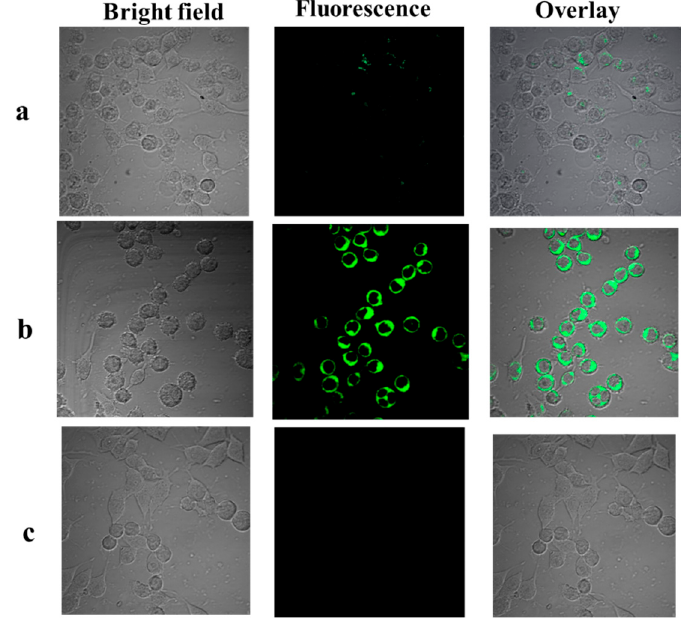
Figure 7. Confocal fluorescence images of HeLa cells. ( Left ) bright-field image; ( middle ) fluorescence image; and ( right ) overlayed image. ( a ) Cells treated with N -ethylmaleimide (NEM) (1 mM) for 30 min followed by incubation with PBD (10 µ M) for 20 min. ( b ) Cells incubated with PBD (10 µ M) for 20 min at 37 °C. ( c ) Untreated cells.